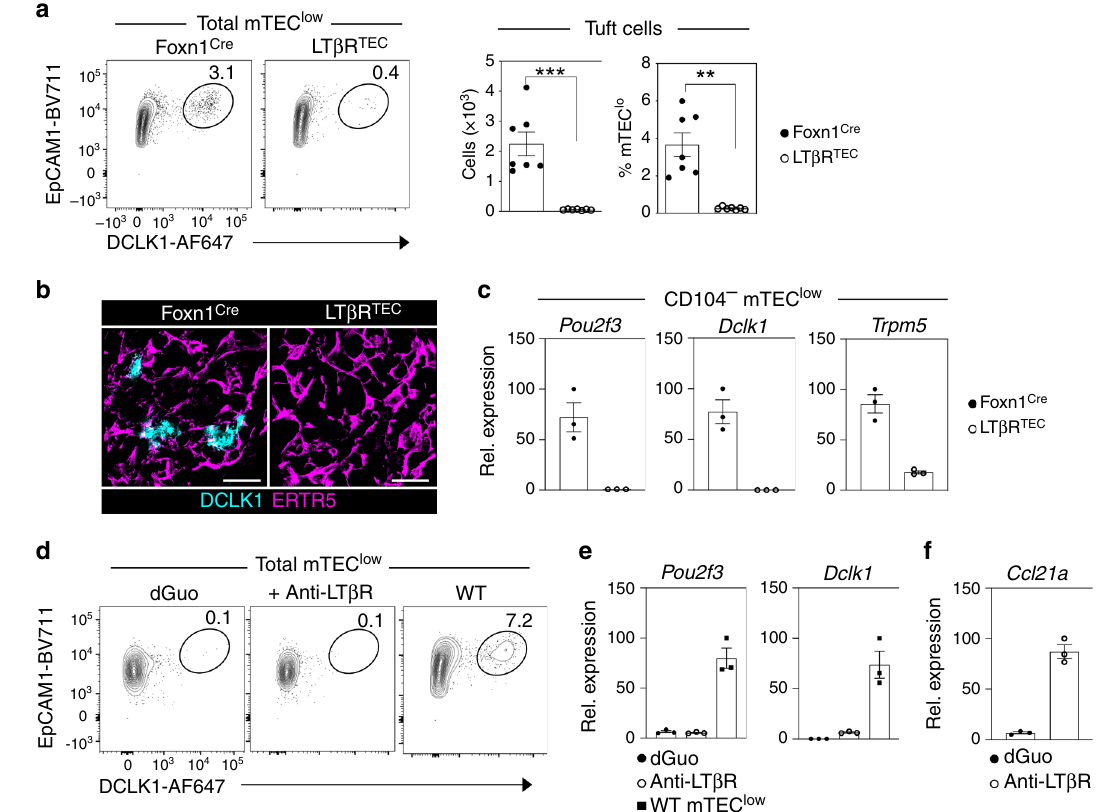
Fig. 2 LT β R regulates thymic tuft cell development. a Intracellular staining of mTEC low from control Foxn1 Cre and LT β R TEC mice for expression of the tuft cell marker DCLK1. Bar graphs indicate absolute cell numbers and percentages within mTEC low in Foxn1 Cre mice (closed symbols) and LT β R TEC mice (open symbols) n = 7 biologically independent samples, over three independent experiments. Signi fi cant P values using two-tailed unpaired t test as follows: no. of tuft cells p = 0.0001, % tuft cells p = 0.002. b Confocal image of thymus section from Foxn1 Cre and LT β R TEC mice, stained for the mTEC marker ERTR5 (magenta) and DCLK1 (cyan), representative of n = 3 independent biological samples. Scale bars denote 20 μ m. c qPCR analysis of CD104 − mTEC low FACS sorted from Foxn1 Cre (closed symbols) and LT β R TEC (open symbols) mice, for expression of the tuft cell markers Pou2f3 , Dclk1 and Trpm5 , data